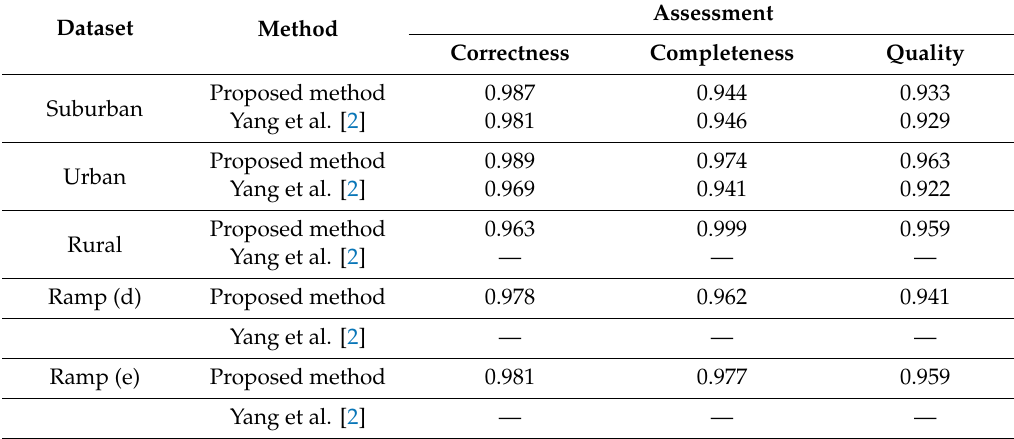
Table 6. Assessment results compared with those from the previous method